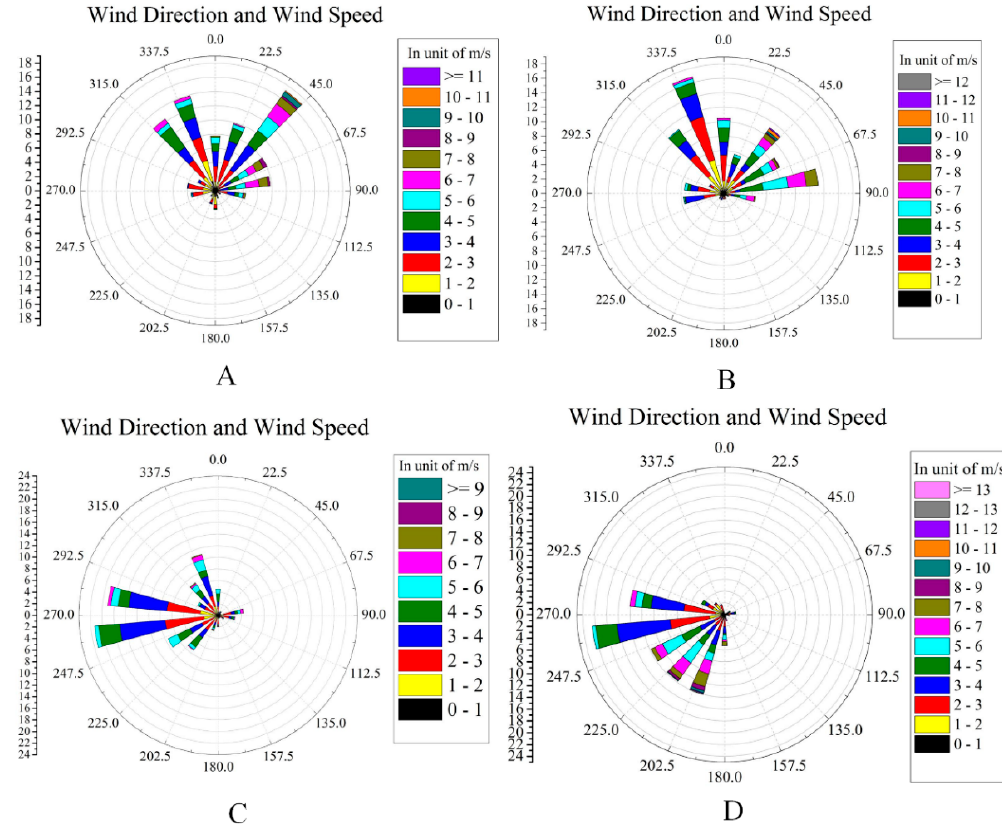
Figure 10. The wind direction and wind speed at June 2007 ( A ), July 2008 ( B ), March 2007 ( C ) and November 2008 ( D ) at Lau Fau Shan meteorological station.